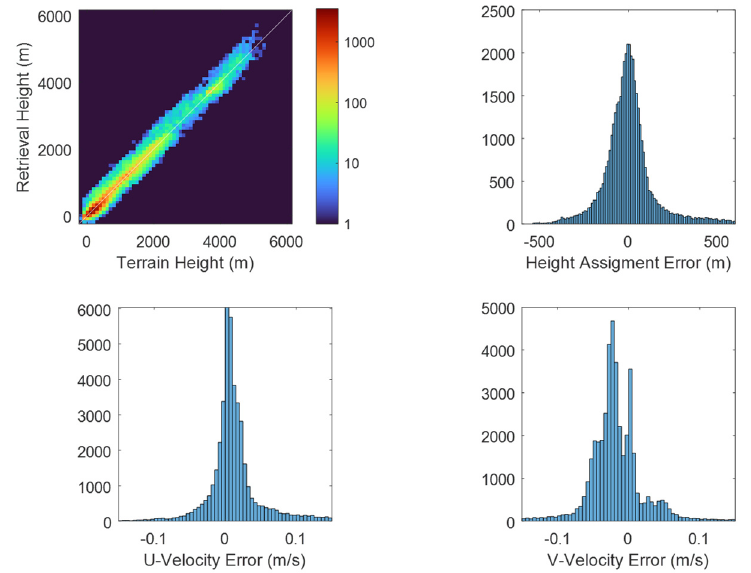
Figure 5. Ground-Point Retrieval Errors for the Merged Stereo Wind Product. Small height assign- ment biases, as indicated in Table 1, have been corrected in the merged product. Note: GOES-18 Preliminary, Non-Operational Data. Table 1. Ground Point Retrieval Statistics. Means ( 𝜇 ) and standard deviations ( 𝜎 ) from a sample size N are calculated with respect the ground truth of the GLOBE digital terrain model. The measured motion with respect to stationary ground is resolved relative to east- and north-pointing directions ( u and v ). Note: GOES-18 Preliminary, Non-Operational Data.